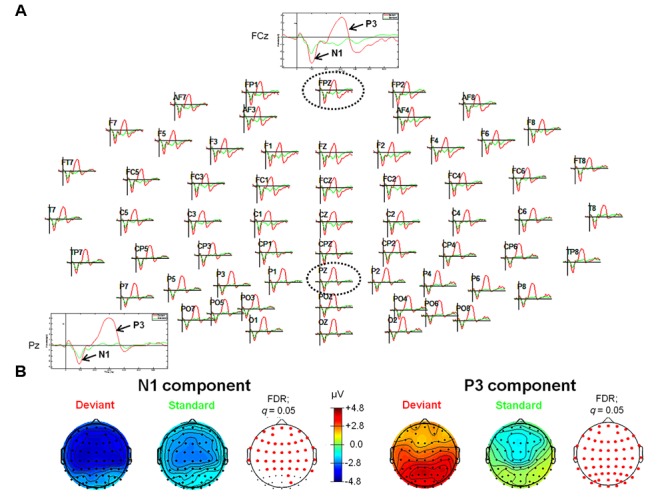
Event-related potentials (ERPs; upper panel, A) and topographic plots (lower panel, B) for the N1 (lower panel, left) and P3 (lower panel, right) components in the experimental conditions of the tone oddball paradigm. (A) The head plot shows ERP waveforms from 62 electrode sites. One anterior electrode site (FCz) as well as one posterior electrode site (Pz) are shown in detail (as indicated by the black dashed circles). ERP waveform plots reveal the N1 and the P3 components with significantly higher amplitudes in response to deviant stimuli (pure tones with a frequency of 1000 Hz) as compared to standard stimuli (pure tones with a frequency of 500 Hz). (B) Reddish colors indicate positive ERP values, whereas bluish colors indicate negative ERP values. In addition, transparent EEG montage arrays (lower panel B) show statistically significant electrode sites as indicated by red dots (after comparison for multiple comparisons with FDR). Obtained time windows have been averaged between 82–129 ms (N1 component) and 233–358 ms (P3 component), respectively. FDR, False discovery rate.